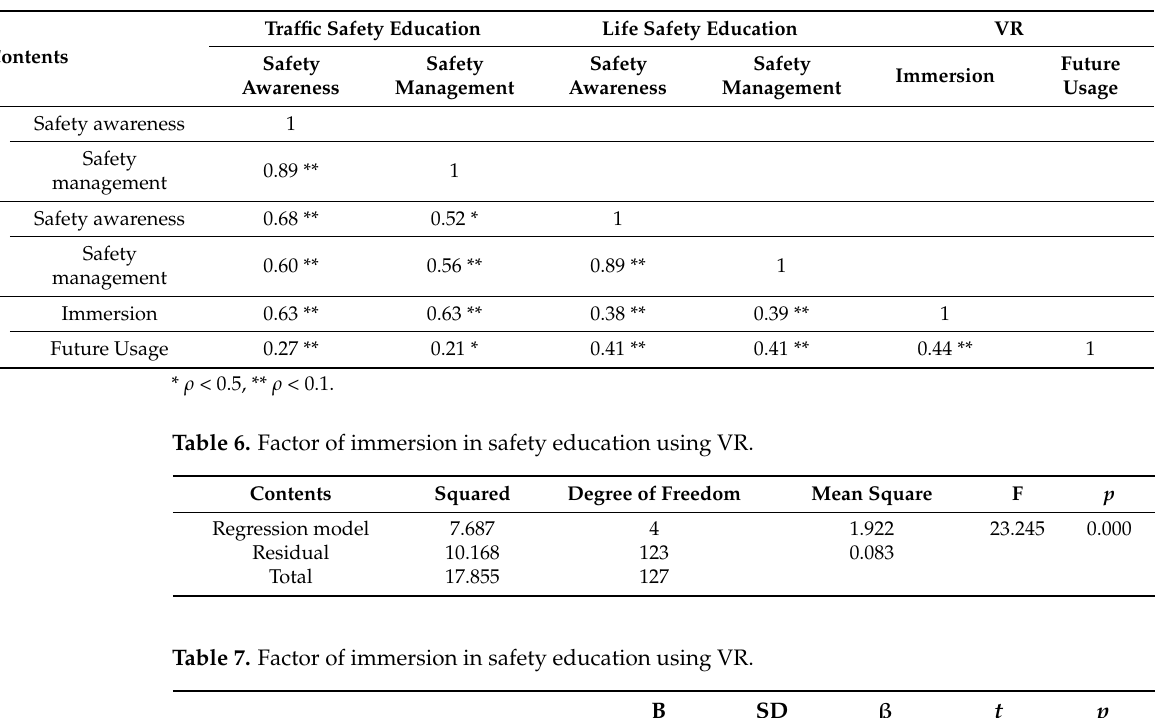
Table 5. Correlation of VR safety education effect.